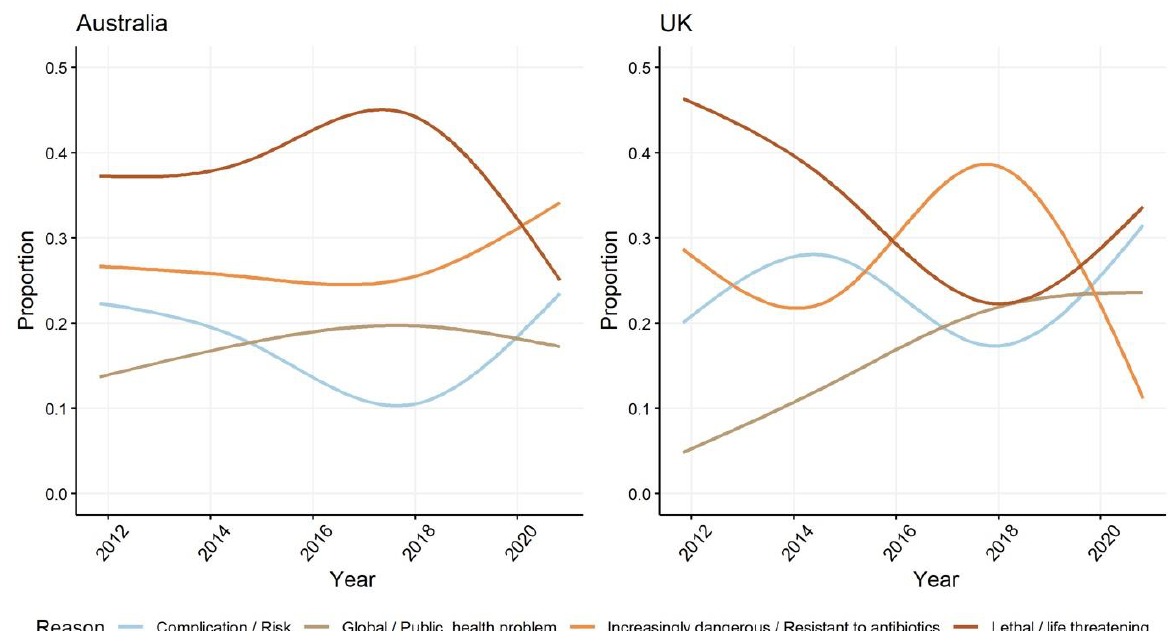
Figure 4. Proportion of different framings in Australian and UK newspapers of the reason why members of the public should care about AMR.